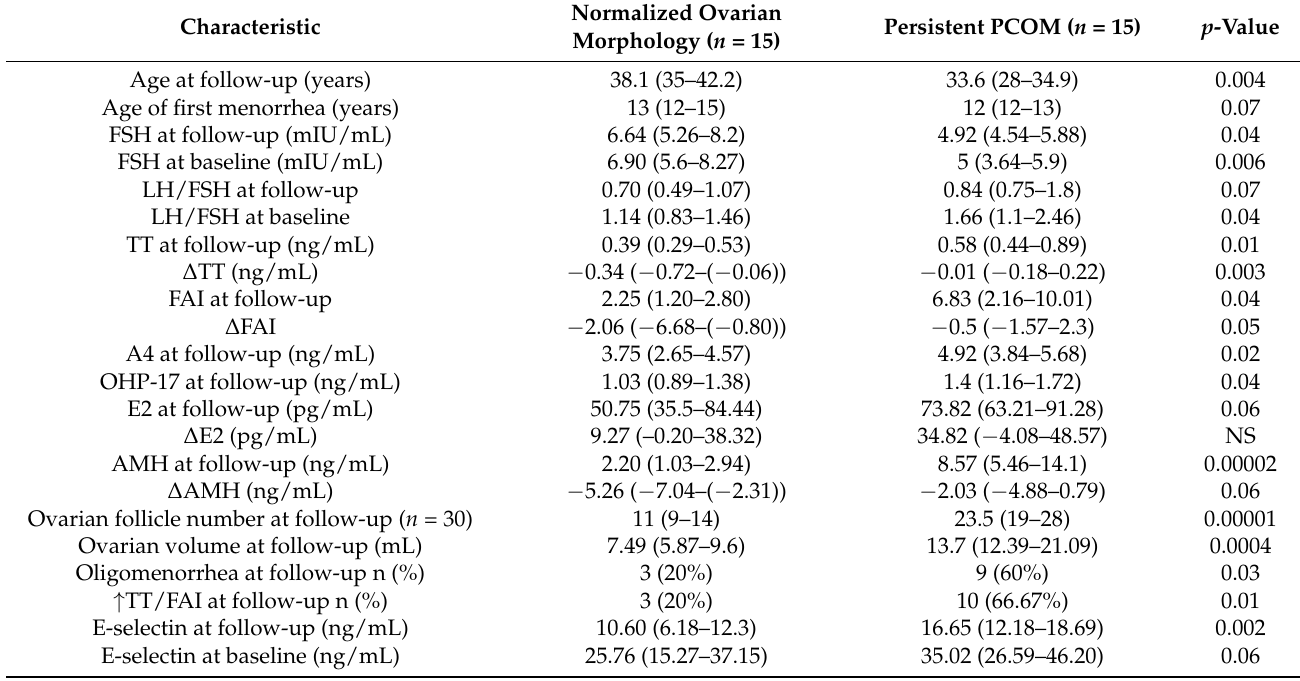
Table 4. Characteristics of the women according to ovarian morphology assessed at the end of the follow-up.